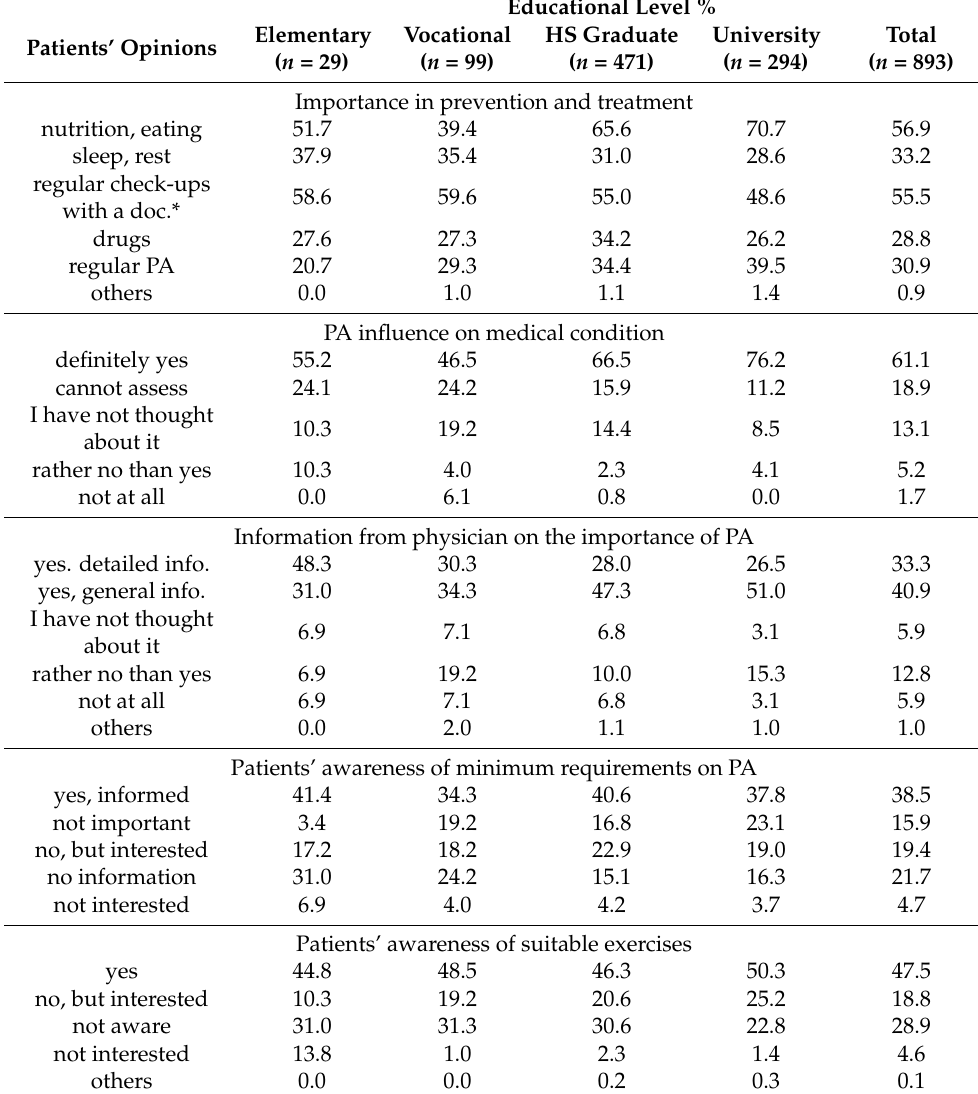
Table 3. Opinions of patients with selected NCDs in relation to